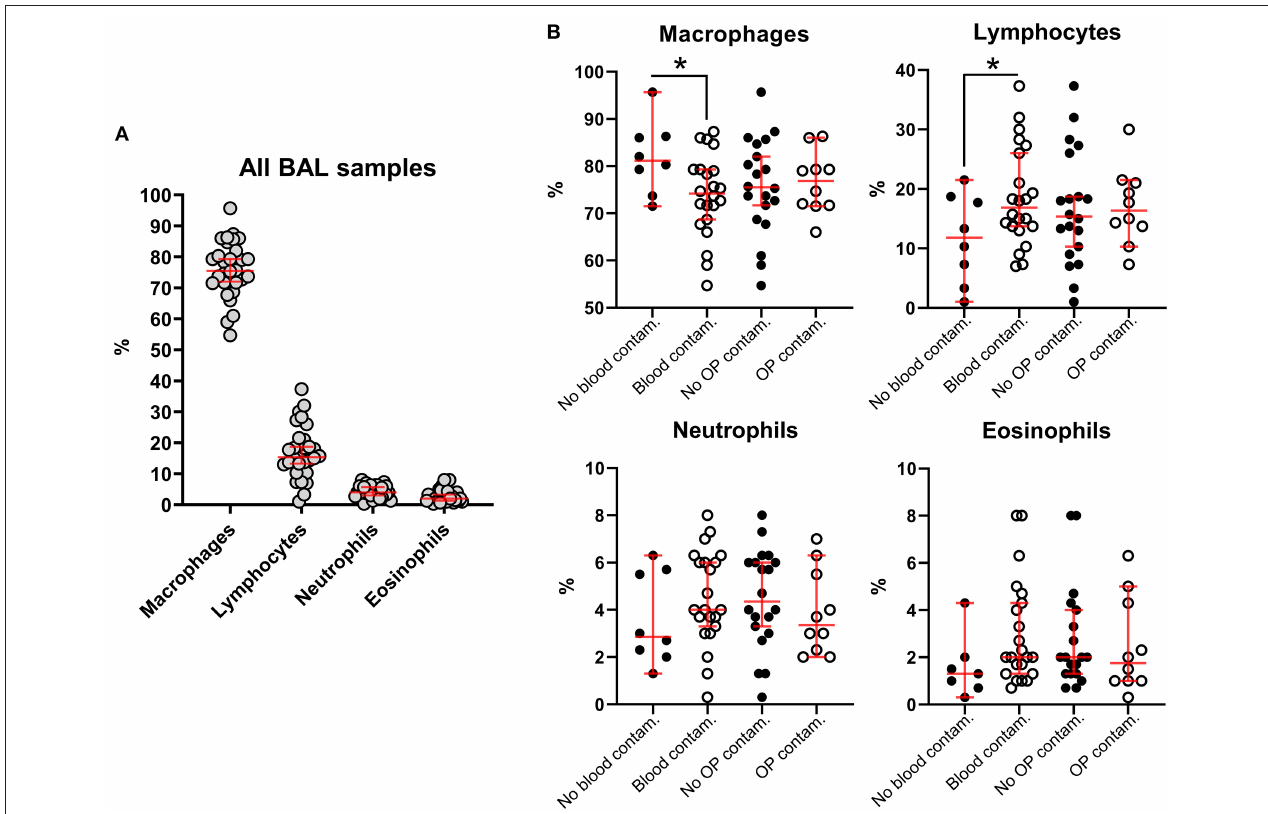
FIGURE 6 | Influence of blood and oropharyngeal contamination on percentages of the different nucleated cell subsets in BALs from healthy macaques. (A) All BAL samples, regardless of blood or oropharyngeal contamination. (B) Cell subsets considering blood and oropharyngeal contaminations. Each dot is representative of one specimen. Bars, medians ± 95% confidence interval; OP, oropharyngeal; Contam., contamination. * P-value <